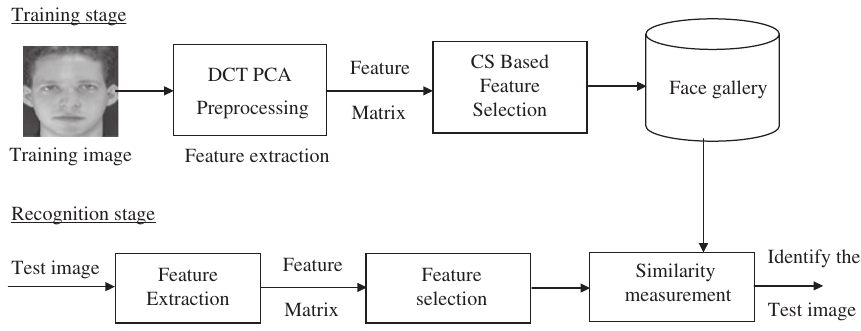
Figure 2: Proposed FR